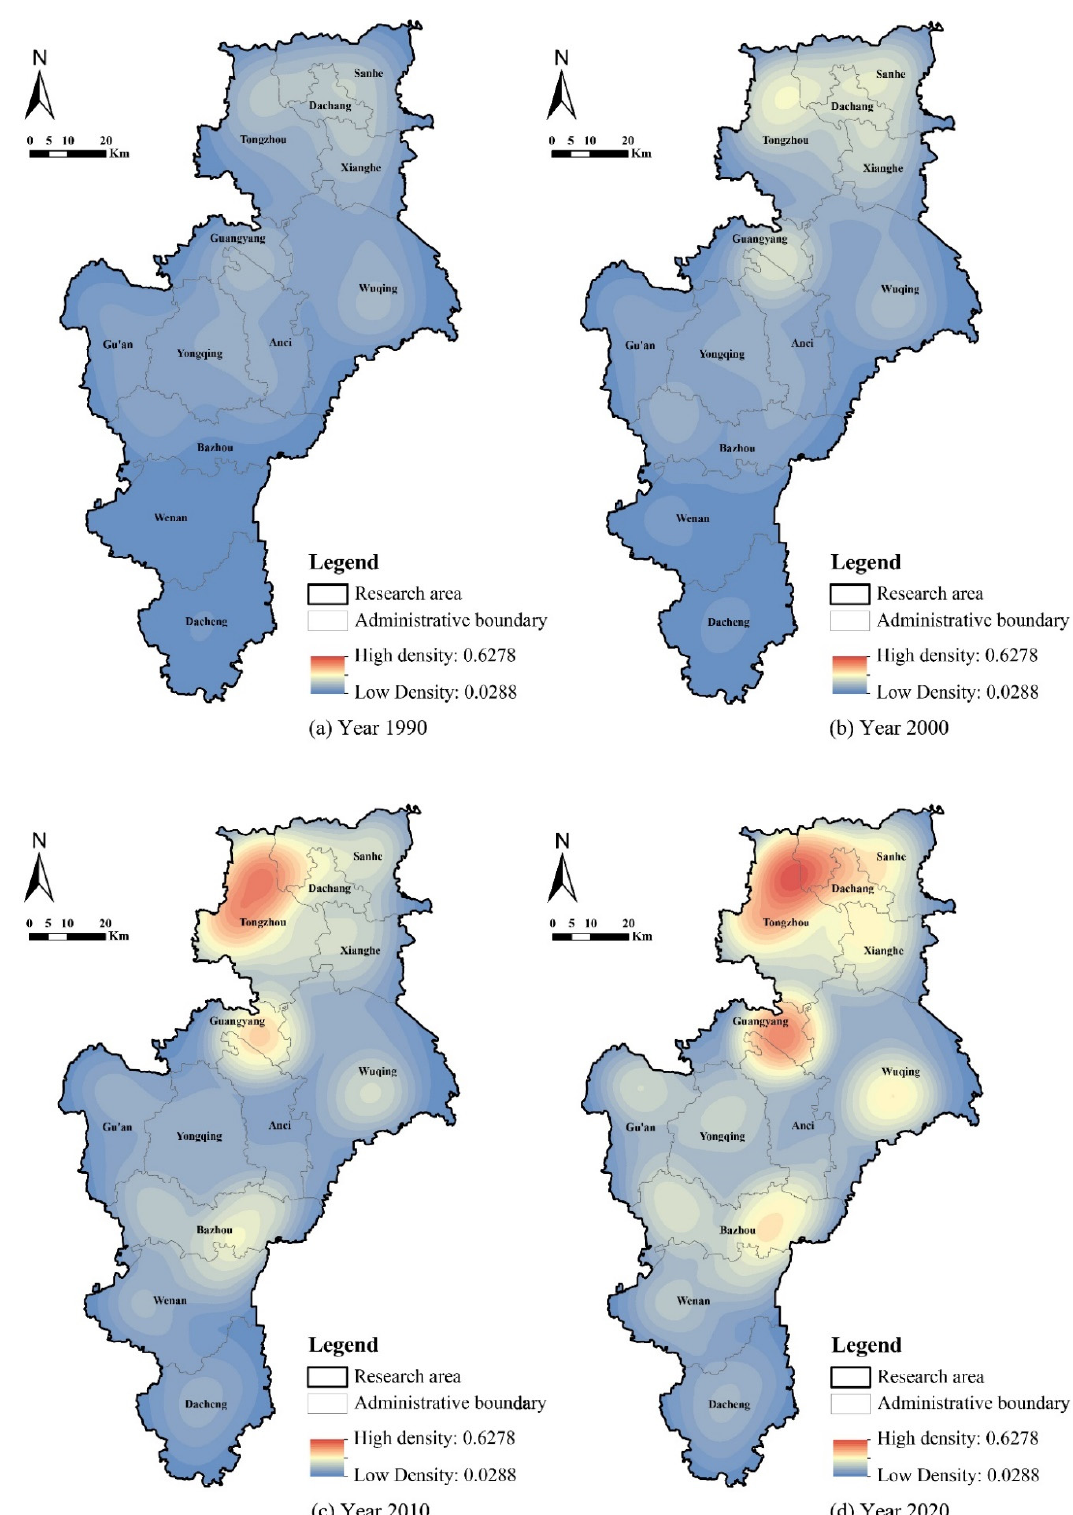
Figure 3. Spatial distribution of land use in the TWL region in ( a ) 1990, ( b ) 2000, ( c ) 2010, and ( d ) 2020 (Source: authors).